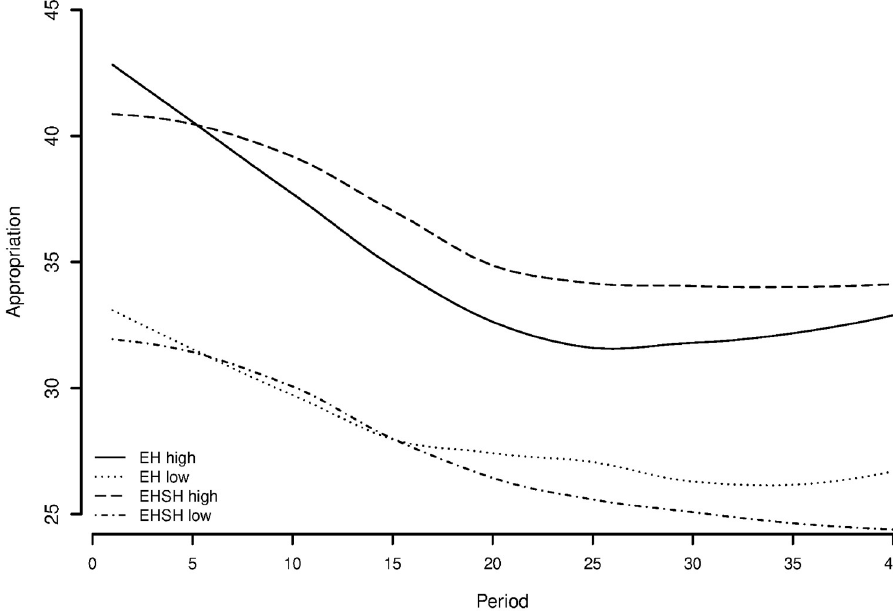
Fig 12. Appropriation of higher ( E = 60) and lower ( E = 40) endowed players in economic heterogeneity [EH] and economic and sociocultural heterogeneity [EHSH] treatment (smoothed line).